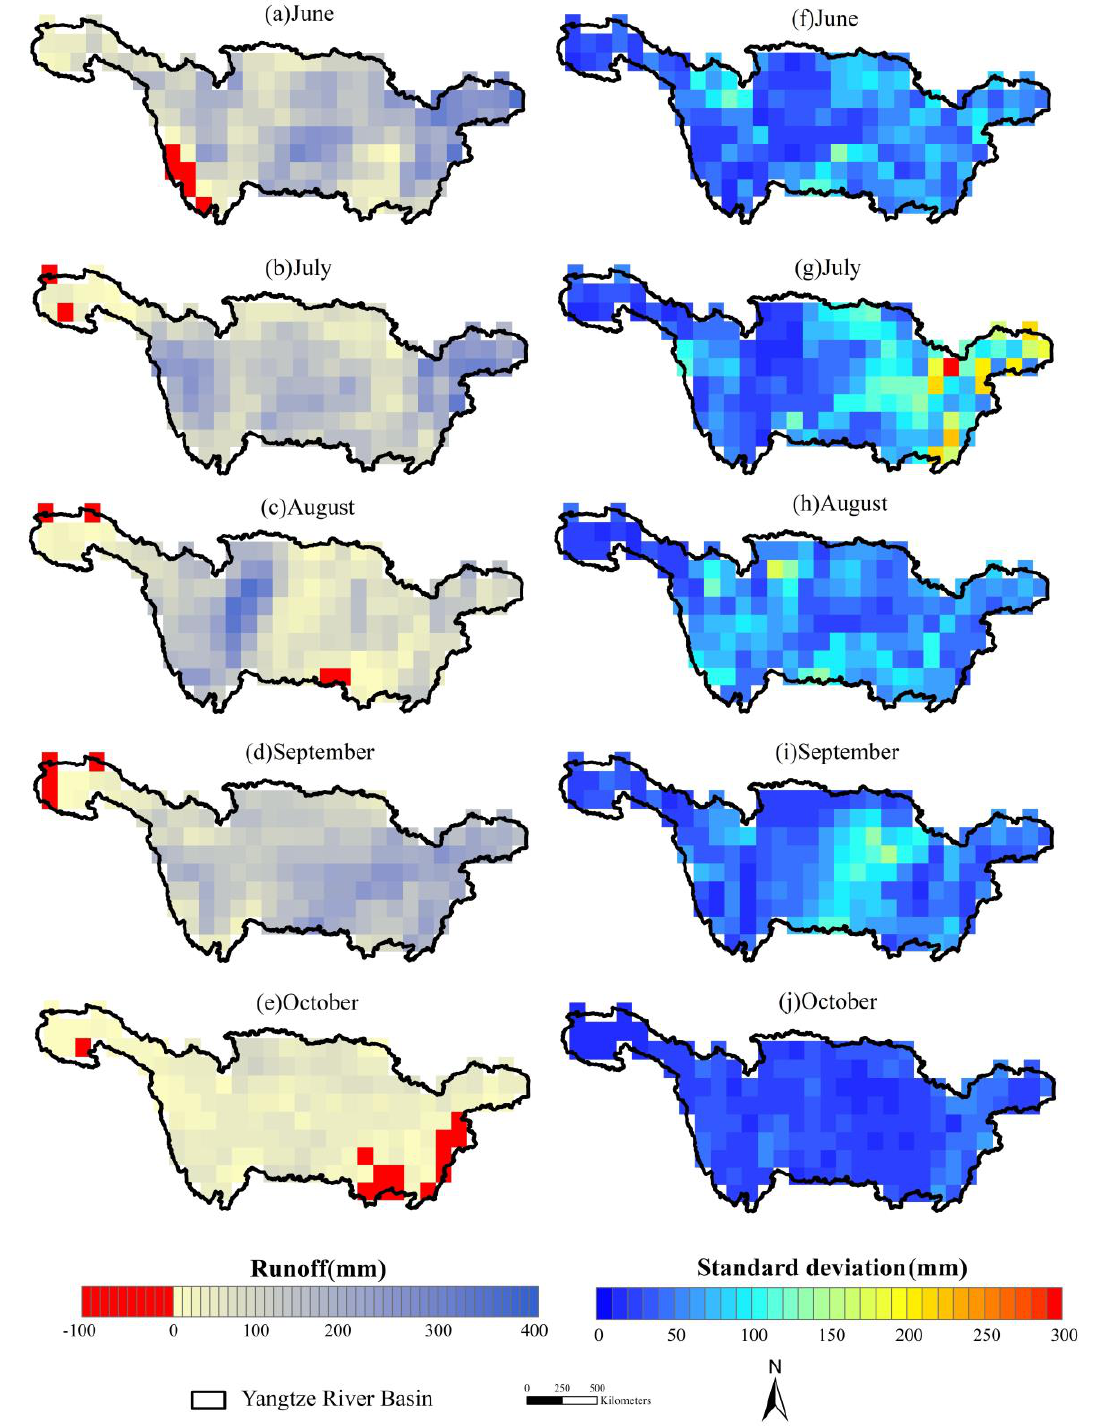
Figure 8. Monthly spatial distribution of ensemble means of GRAFO-derived runoff (left panel) and their standard deviation (right panel) in the Yangtze River basin from June 2020 to October 2020.